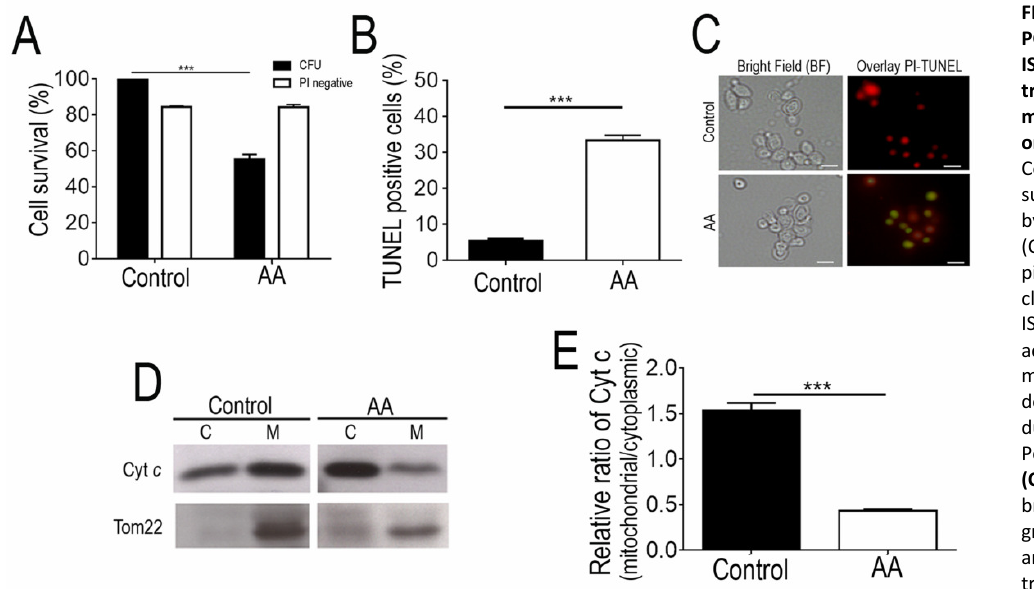
during 200 min. (B) Percentage of cells and (C) epifluorescence and bright field micro- graphs of untreated and acetic acid (AA)- treated strain ISA1307 cells displaying